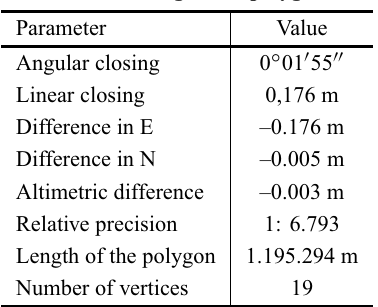
Data of closing of the